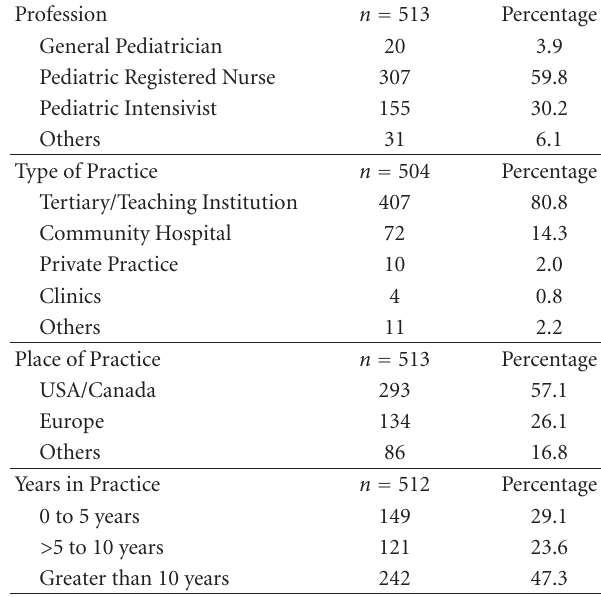
Table 1: Descriptive statistics of responder